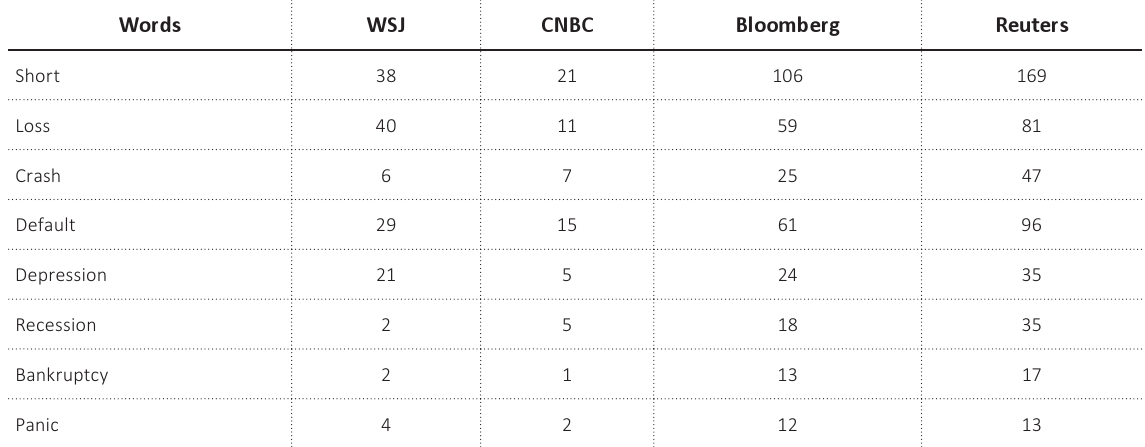
Table 1. Words search inserted on the news from 2004 till 2020, April 16 th (million)